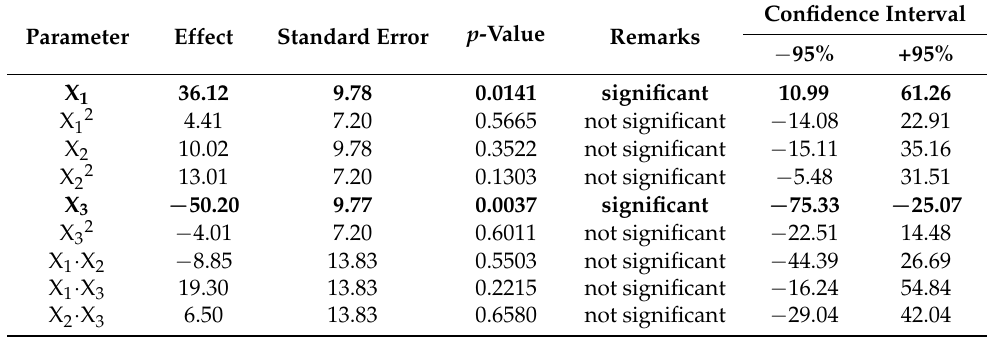
Table 3. Effect estimates for the effectiveness of caking prevention of fertilizers after granulation (Y 1 ).